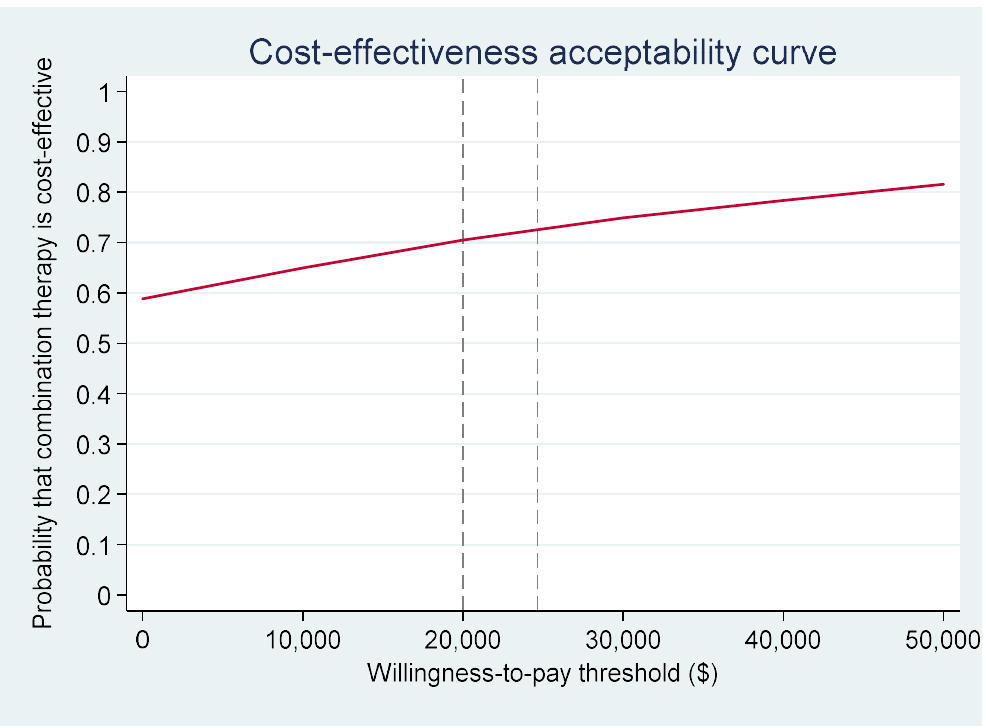
Int. J. Environ. Res. Public Health 2021 , 18 , x FOR PEER REVIEW Figure 3. Cost–Effectiveness Acceptability Curve (healthcare payer perspective).